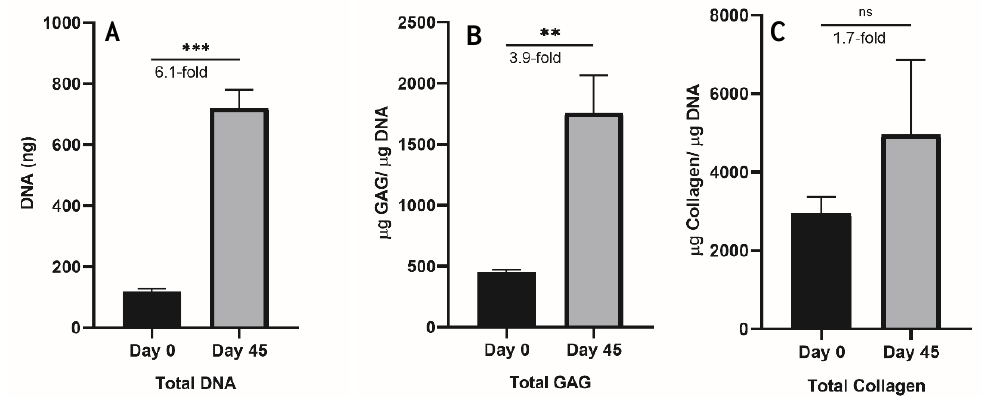
Figure 7. ( A ) DNA quantified using Quanti Fluor dsDNA for bAChs at day 0 and after 45 days of culture in SA – GEL – GA (n = 4, mean ± SEM, ** p < 0.01, *** p < 0.001). ( B ) Amount of GAGs quantified using DMMB assay normalized by DNA for chondrocytes at day 0 and day 45 cultured in SA – GEL – GA (n = 4, mean ± SEM, * p < 0.05). ( C ) Amount of collagen quantified using Sirius red assay nor- malized by DNA for chondrocytes at day 0 and day 45 cultured in SA – GEL – GA (n = 4, mean ± SEM, * p < 0.05, ns p > 0.05).